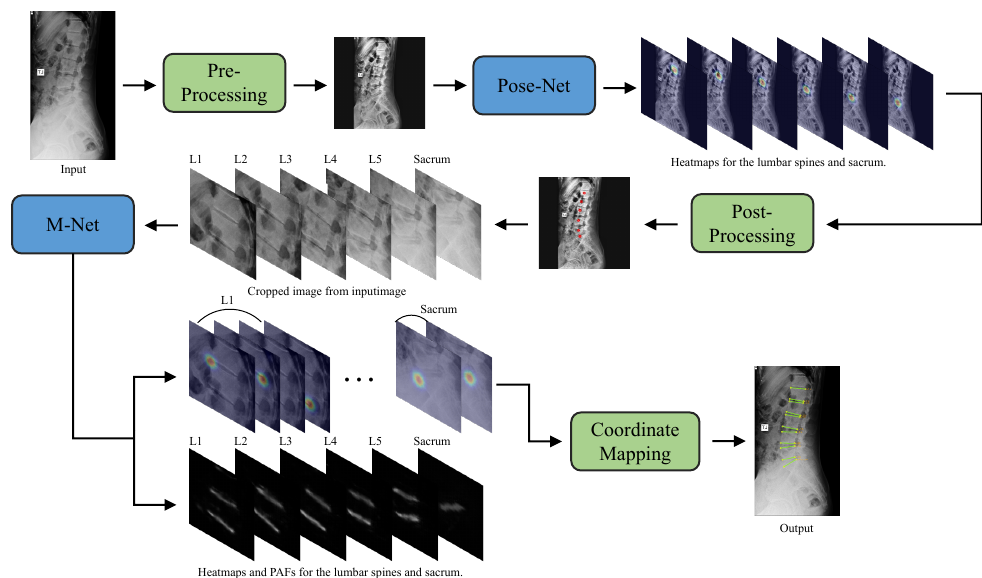
Figure 2. An overview of the proposed network. The blue boxes denote the neural network and the green boxes denote the algorithmic